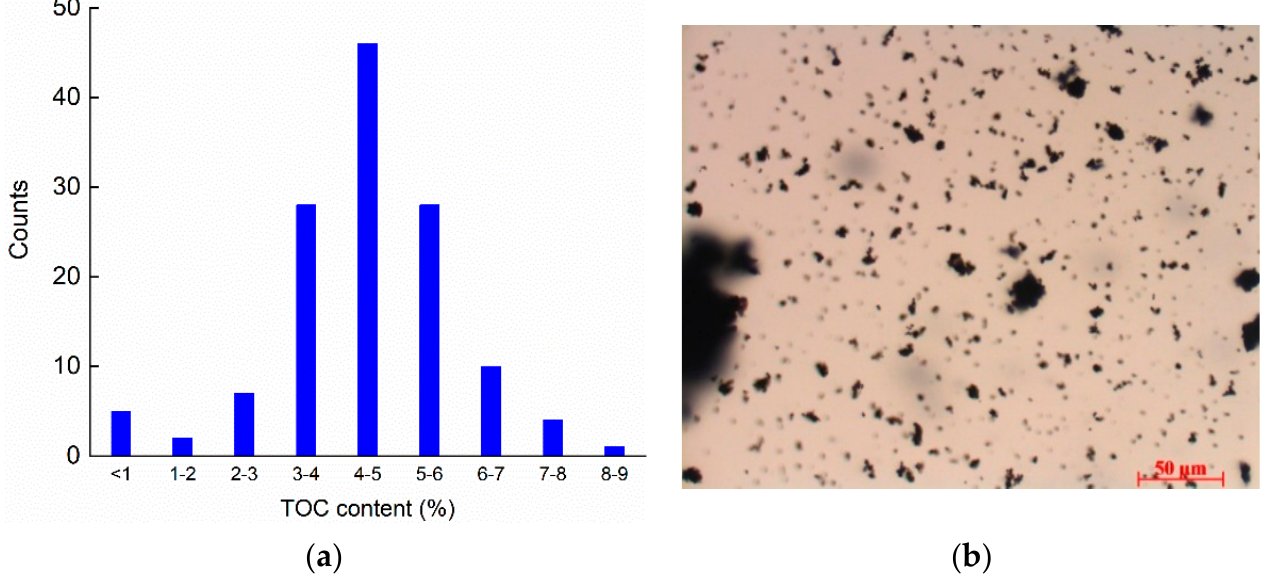
Figure 5. Organic matter characteristics of the investigated gas shales on the Anchang Syncline: ( a ) Histogram of the TOC content and ( b ) amorphous macerals of the sapropel (black) in shales at the Anchang syncline, observed using an optical microscope under transmitted light.